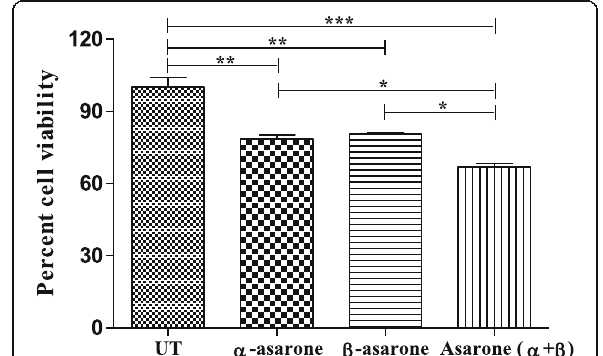
Fig. 2 The combined cell viability activity of α + β -asarone (0.61 mM + 0.73 mM) was more effective than the single entity of either α - or β -asarone (0.61 mM or 0.73 mM) when compared to the untreated (UT) group. Values represent mean ± SEM of an experiment done in triplicate; one-way ANOVA followed by Bonferroni test, where * p <